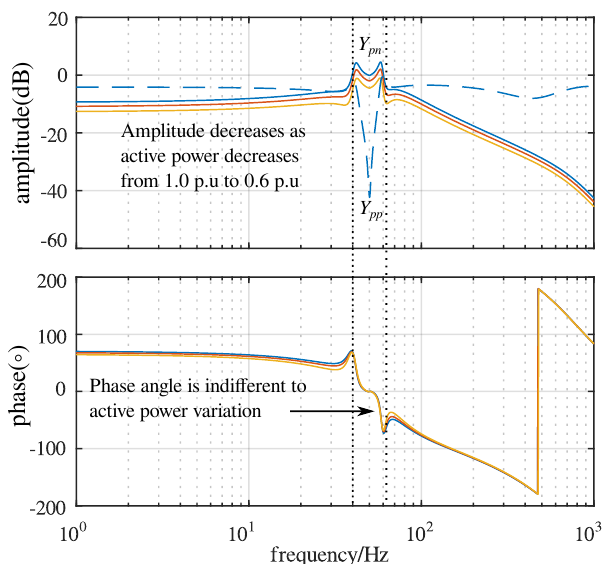
Figure 8. Bode diagram of off-diagonal GSC admittance elements against active power variation. The dashed line is the amplitude of diagonal elements indicating the weight of off-diagonal admittance elements on the overall terminal frequency characteristic of the